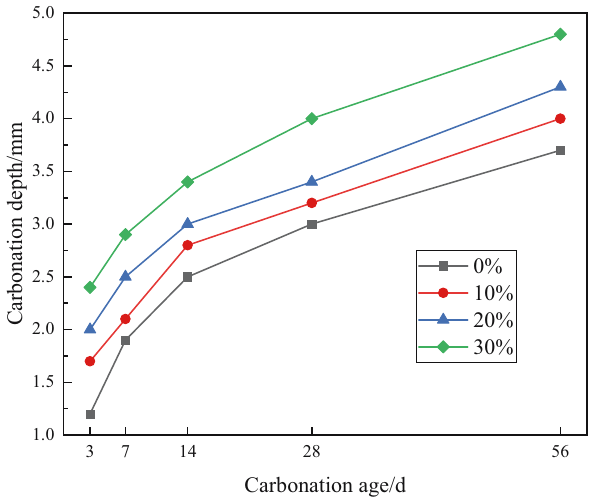
Figure 5: Relationship between carbonation depth and carbonation age [ 29 ]